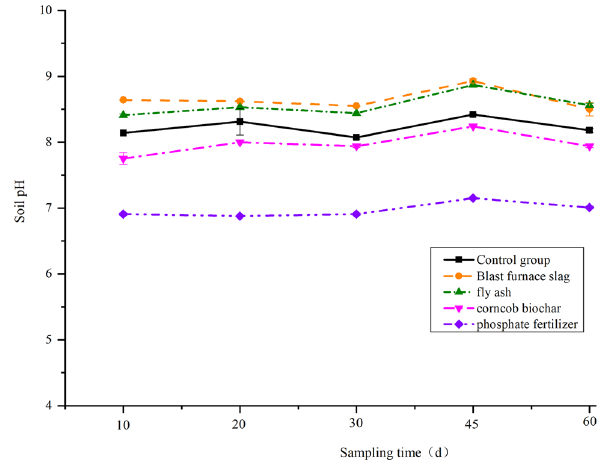
Figure 1: Variation of soil pH after addition of di ff erent passivation